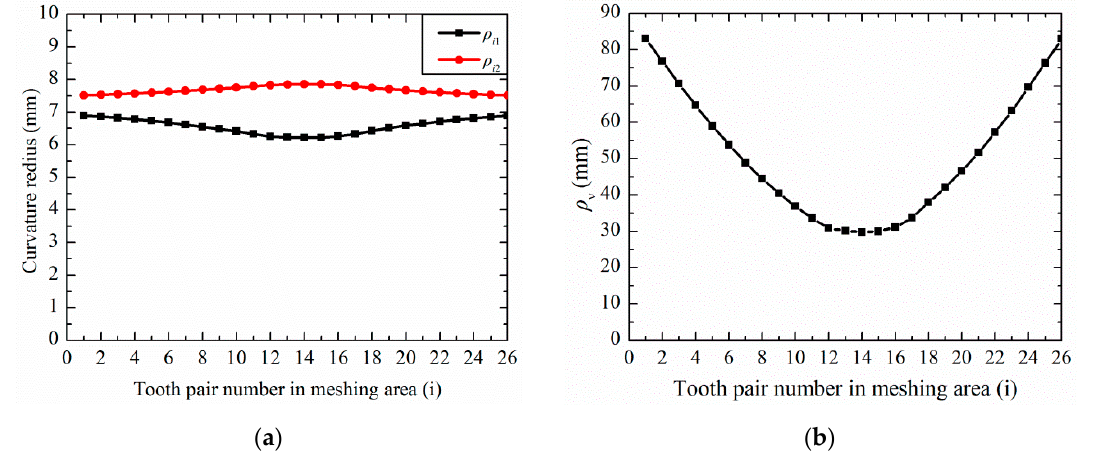
Figure 12. ( a ) Curvature radii of the flexible and rigid wheel; ( b ) comprehensive curvature radius. The tooth surface contact stresses of the two kinds of HDs under full load are shown in Figure 13.